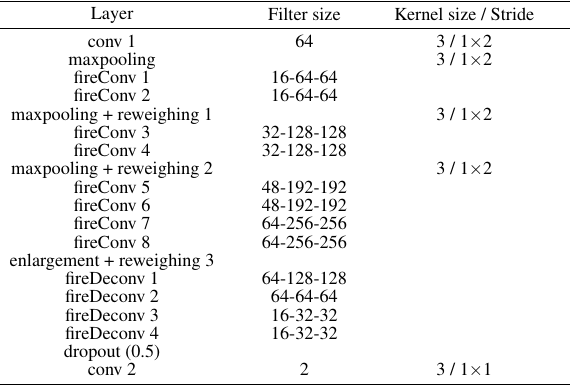
Table 1. Network parameters of mask prediction layers. For fireConv and fireDeconv layers, the filter size is represented as C 1 − C 2 − C 3 as shown in Figure 3.